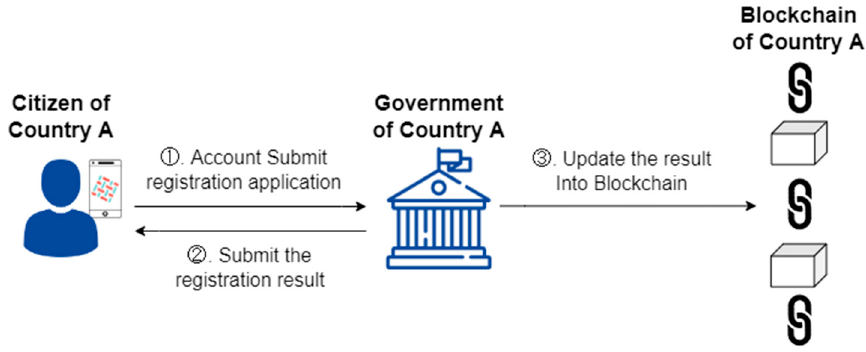
Figure 4. DApp account application scenario.